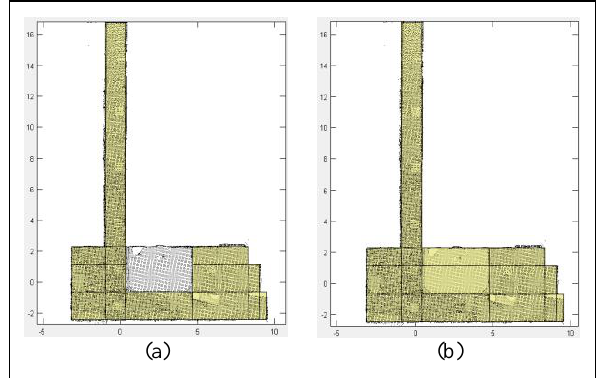
Figure 12. Cuboid placement in the real point cloud. Two cuboids are missing (a) because there are no points on the ceiling (see also Figure 10). These were placed manually by temporarily disabling the points-on-ceiling constraint (b).